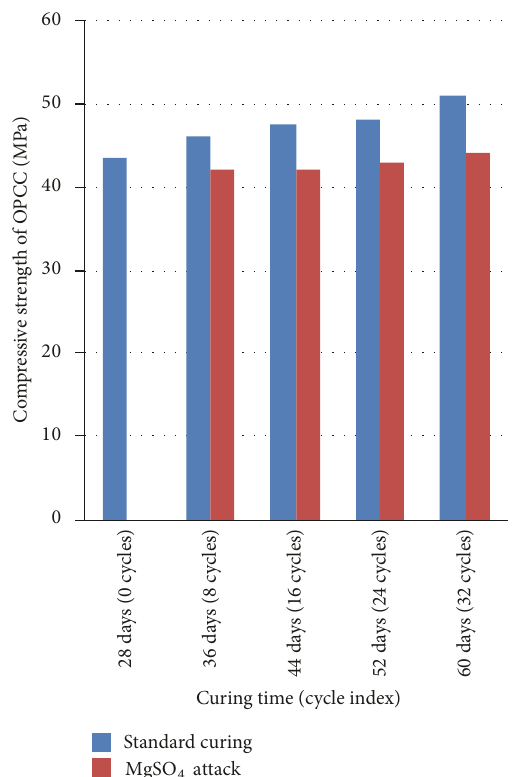
Figure 3: Compression strength evolution of OPCC in the standard curing condition and MgSO 4 attack,